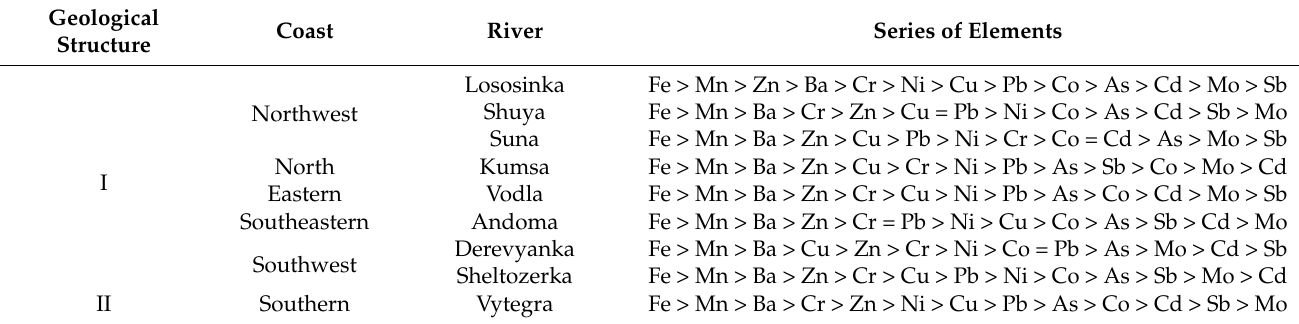
Table 6. Series of elements to reduce therole of the weighted form in the tributaries of Lake Onego.